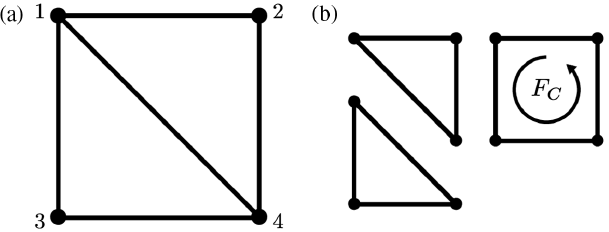
FIG. 1. Transition graphs and cycles. (a) Representative tran- sition graph for a four-state system, which acts as a recurring illustrative example. (b) Cycles around which the cycle forces F C drive the system out of